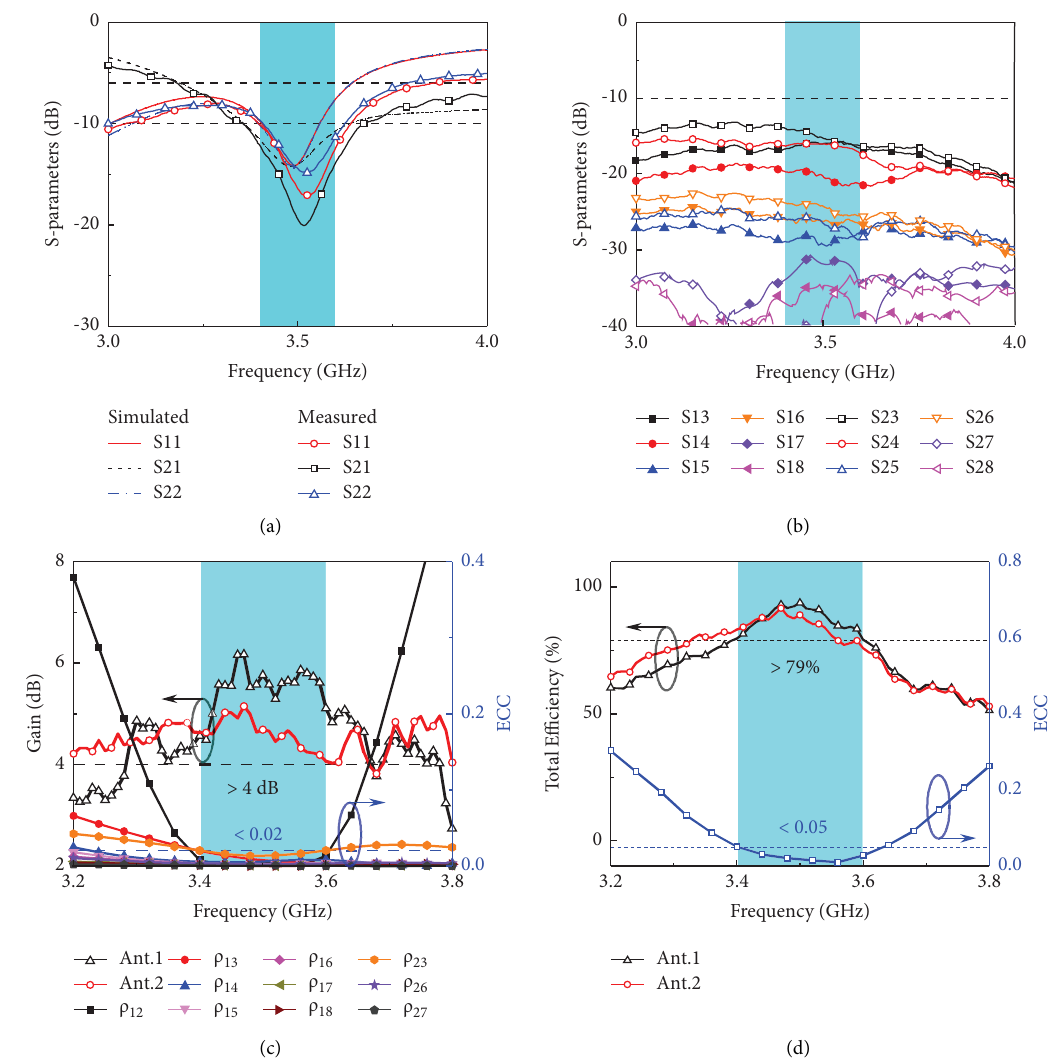
Figure 8: (a), (b) Simulated and measured S -parameters of the proposed 8 × 8 MIMO antenna; (c), (d) measured total gain, simulated ECC between diferent units, efciency, and the calculated ECC of Ant.1 and Ant.2 in the proposed 8 × 8 MIMO